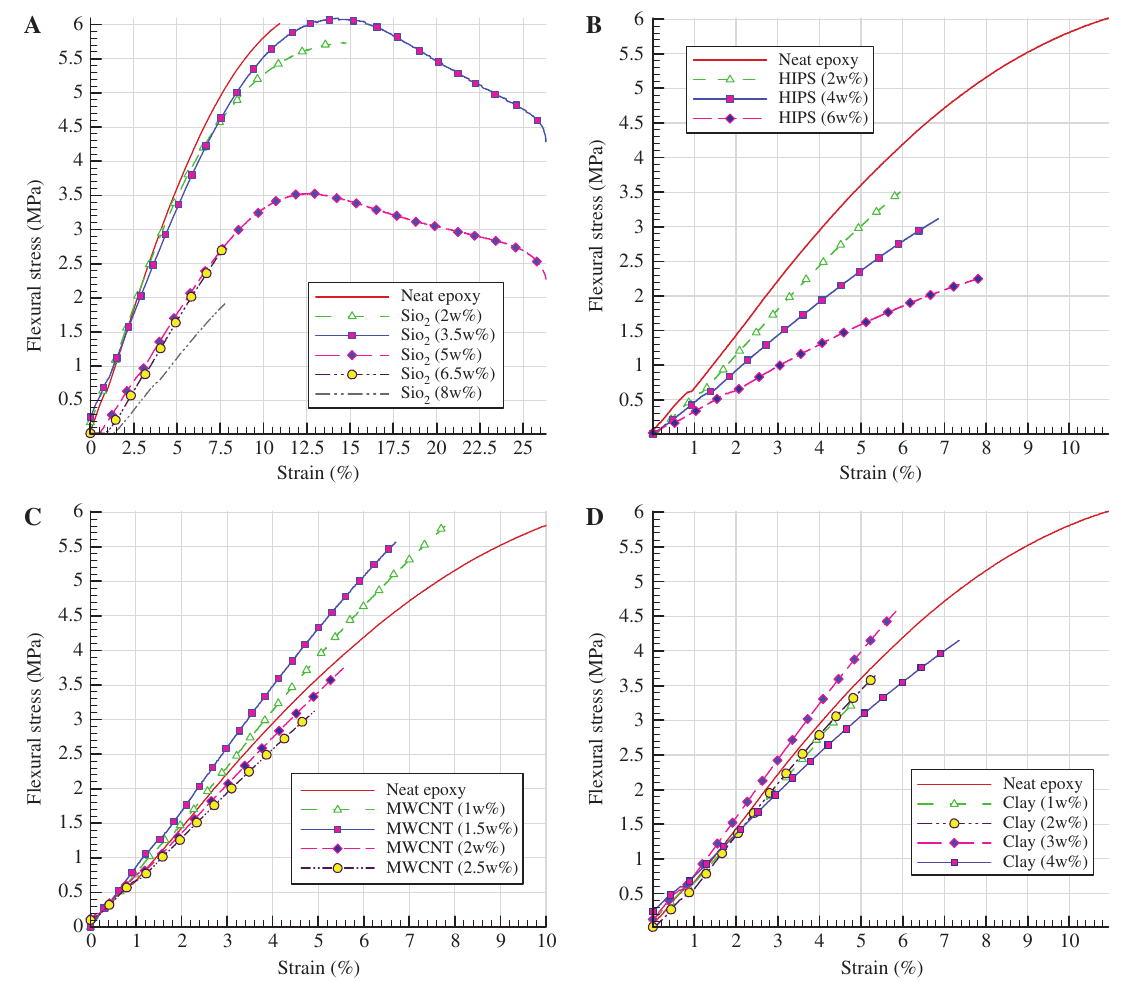
, (B) epoxy/HIPS, (C) epoxy/MWCNT and (D) 2